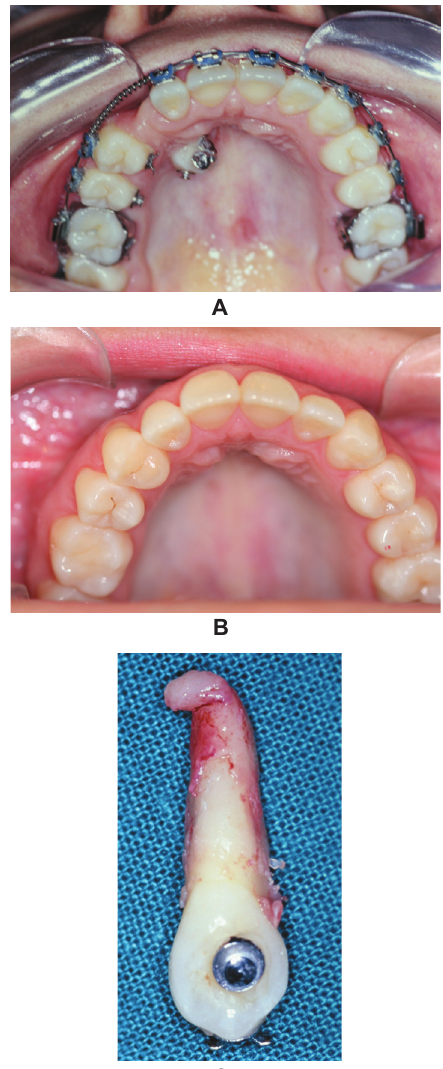
Figure 2- Palatal view. A. Preoperatory. Tooth 13 partially erupted in a transalveolar position with the crown mesially inclined. Note the presence of three orthodontic traction devices. B. Clinical control of 10 years and 10 months postoperatively, with orthodontic appliance removed for 10 years and 3 months, thus confirming stability. Vestibular and palatal gingival contour is maintained. C. Extracted maxillary right canine. Severe apical dilaceration is observed, along with areas compatible with